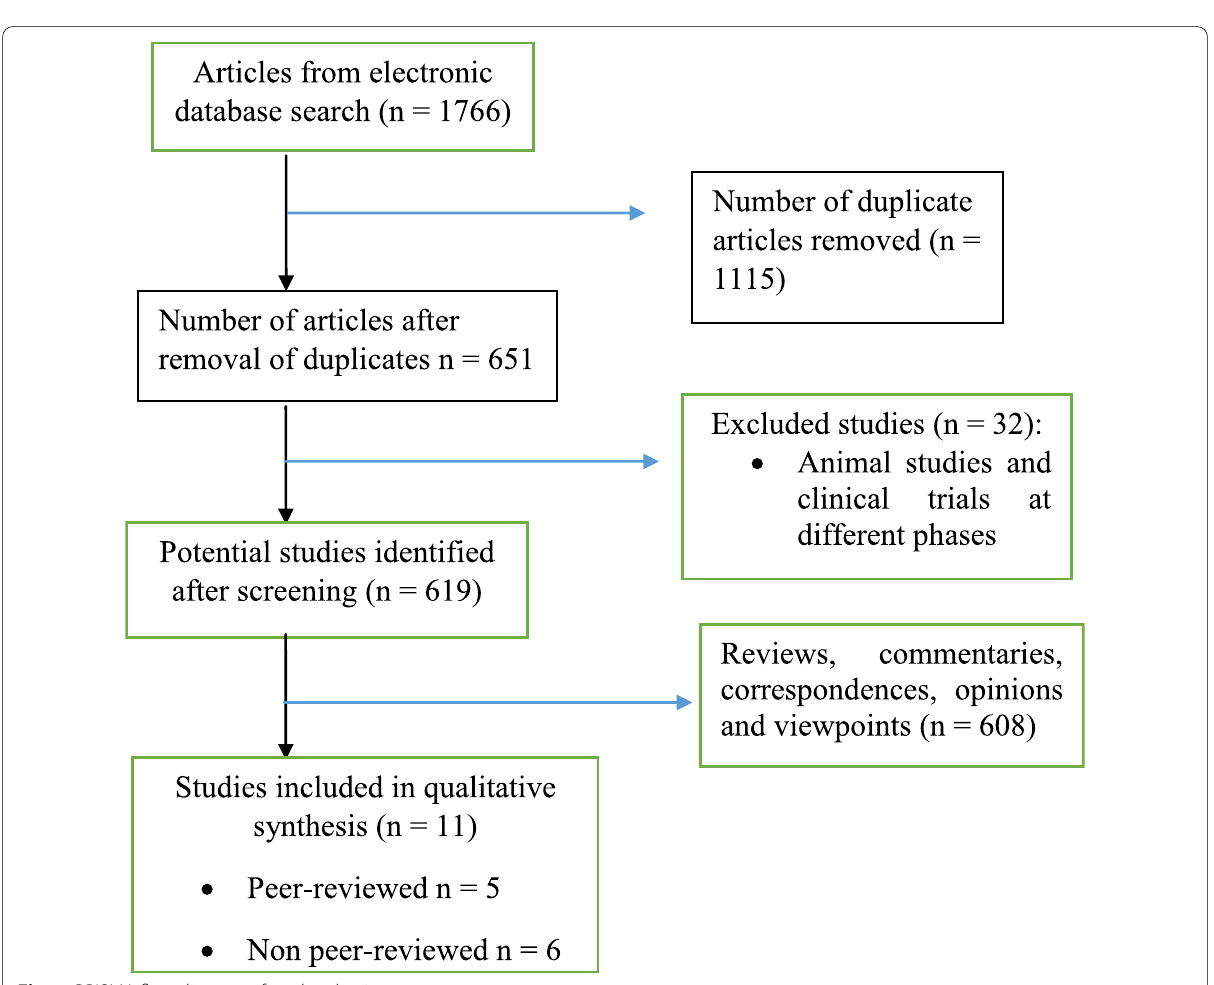
Fig. 1 PRISMA flow diagram of study